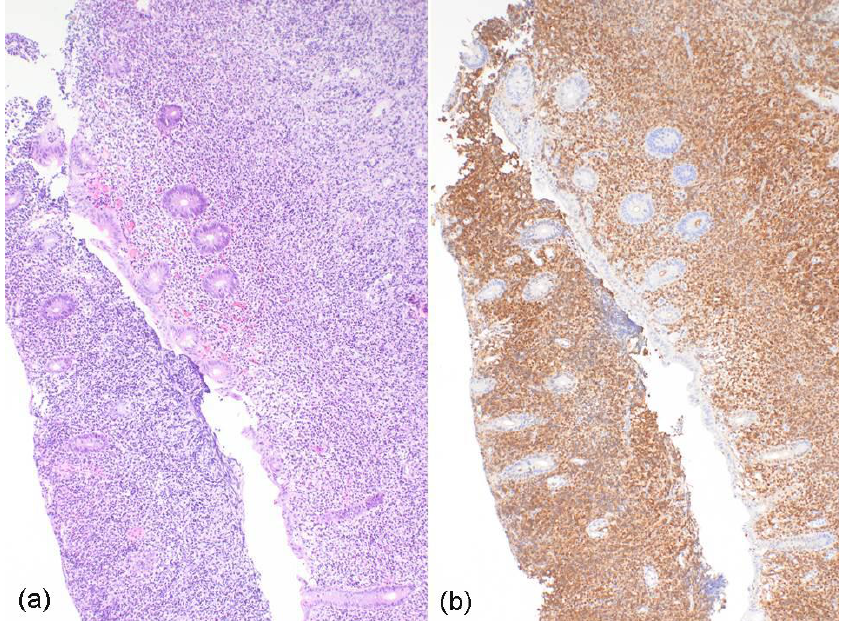
Figure 3. ( a ) Hematoxylin and eosin staining (10× magnification) of colonic mucosa, showing rarefied crypts, extensive erosions, and a dense and diffuse infiltration of the lamina propria by lymphocytes. ( b ) Immunohistochemistry (10× magnification) for CD20 shows strong staining in the diffusely infiltrating lymphoid cells. These neoplastic B cells were also positive for germinal center markers, such as CD10 and BCL6.